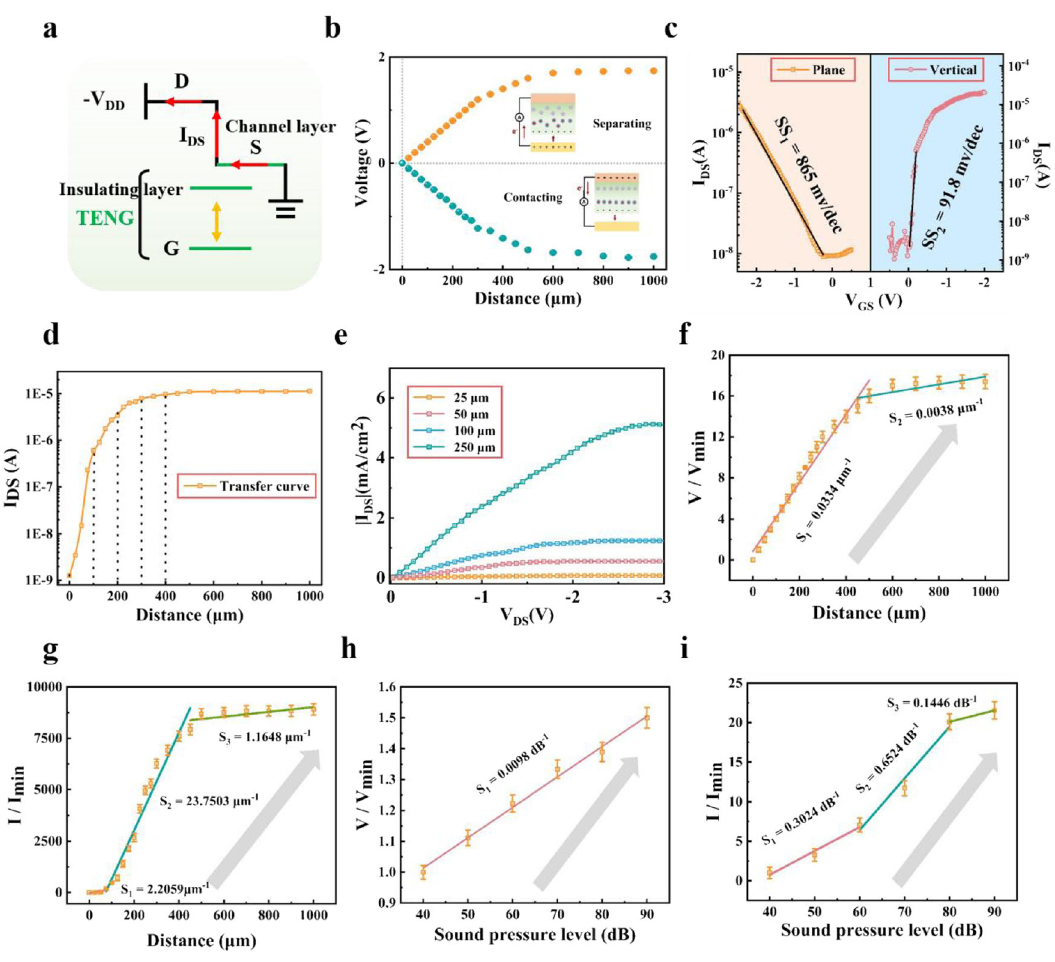
Fig. 2 | The electrical output and sensing properties of TENG and VTT. a Equivalent circuitof the VTT device. b The TENG output voltage versusdistance. c The SSof VTT with externalgate voltage. d , e Transfercurve and output curve of VTT with TENG. f , g The tactile sensitivity of single TENG and VTT with different